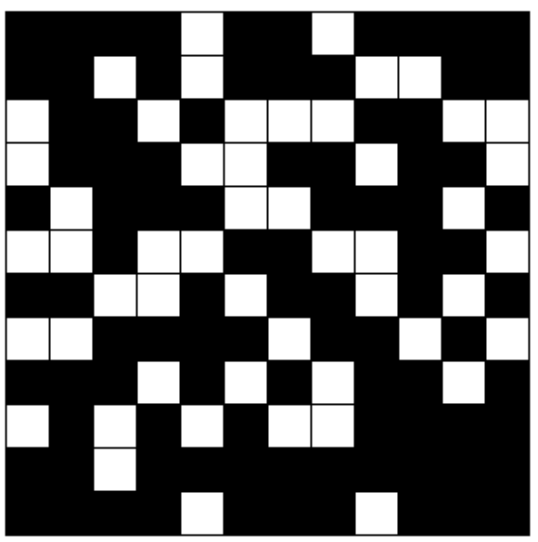
Figure 4. An example black and white, 12 × 12 grid depicting a 128-bit binary value; in which the colour of each cell corresponds to the value of individual bits within the value.